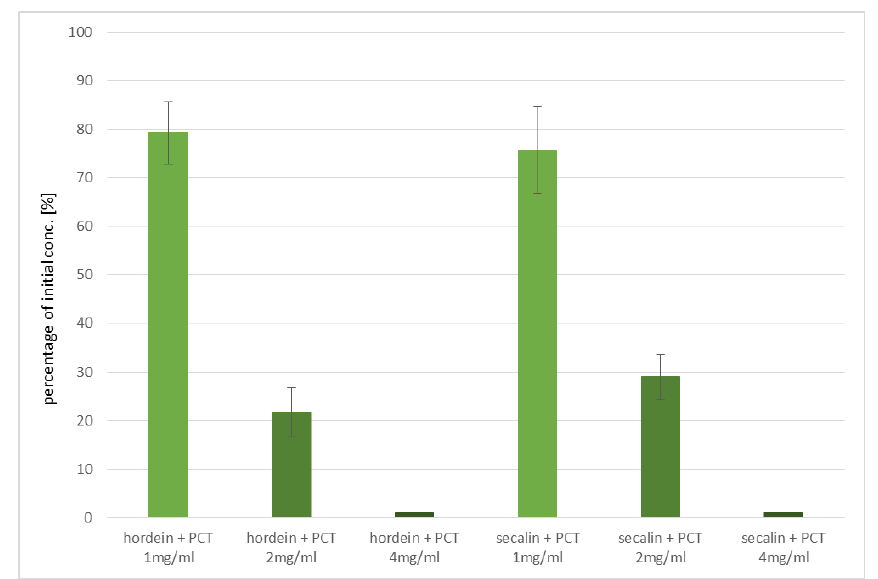
Figure 5. Prolamins from barley and rye adsorbed to purified clinoptilolite-tuff. Solutions containing either secalins or hordeins were incubated at 37 °C with and without PCT for 60 min. Then, the remaining prolamins in the single solutions were determined by ELISA.